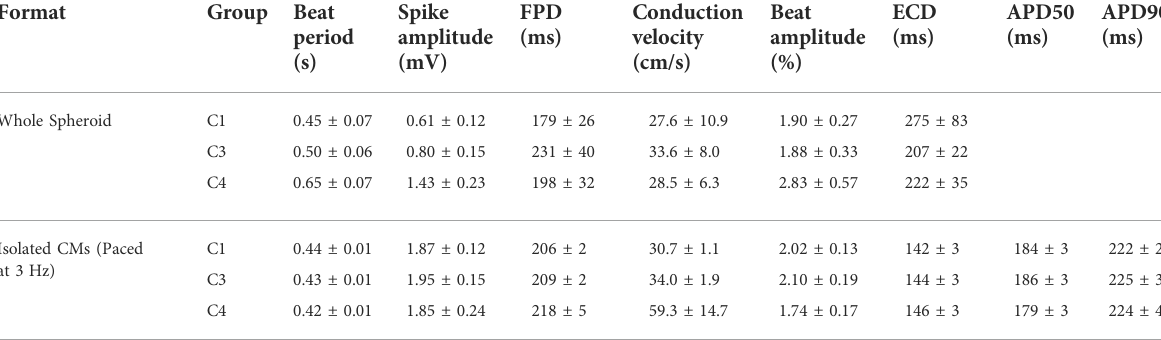
TABLE 1 Data collected from MEA analysis of whole and dissociated